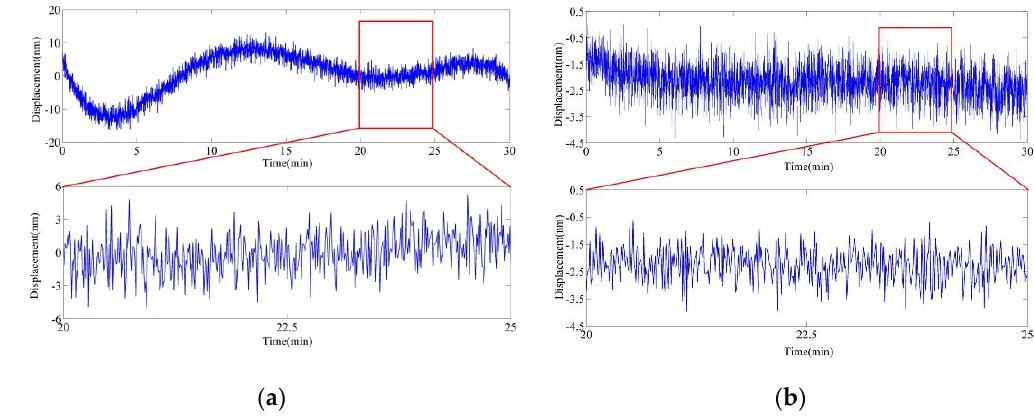
Figure 7. Experimental stability results on interferometer for evaluation of amplitude modulation (AM) performance in EMLMA. ( a ) Long- and short-term stability before AM. ( b ) Long- and short-term stability after AM.